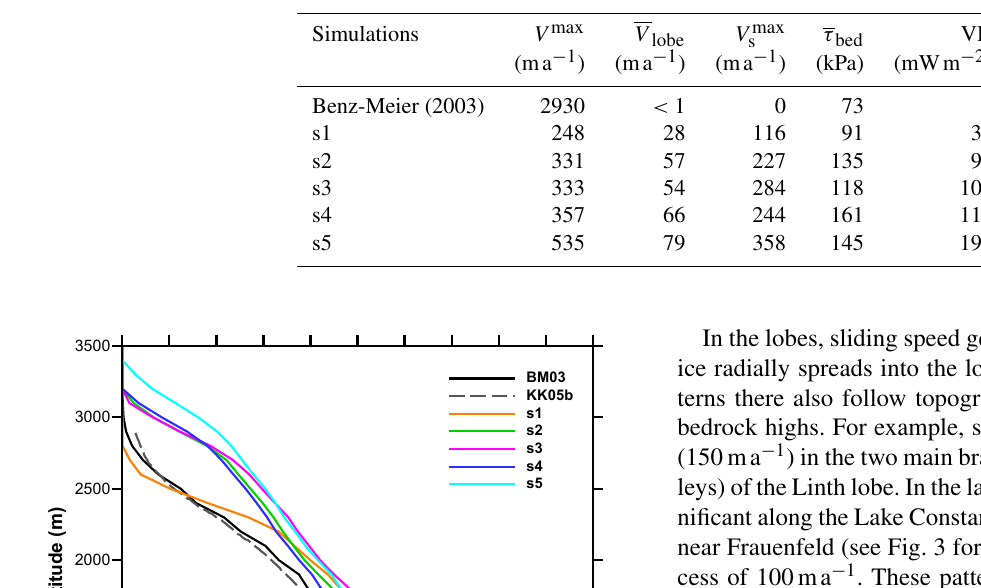
Table 3. Summary of ice dynamics quantities. V max is the maximum surface velocity. V lobe is the average surface velocity in the Rhine lobe. V max s is the maximum sliding velocity. ¯ τ bed is the average basal shear stress over the entire glacier bed. VH is the mean vertically integrated strain heating.